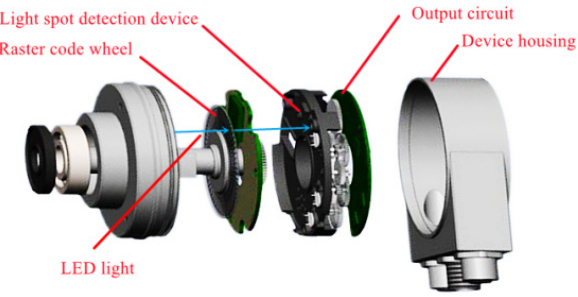
Figure 1. Photoelectric encoder explosion structure